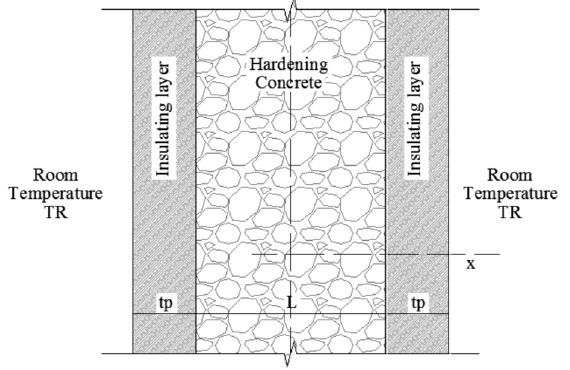
Figure 1. Geometrical description of the 1-D problem (adapted from [19]).